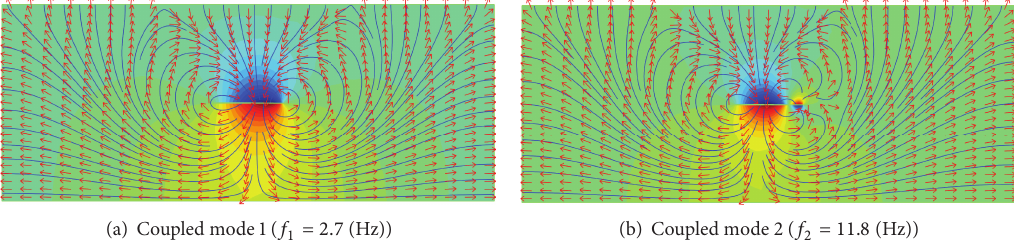
Figure 3: The colors pertain to the pressure field and the arrows to the velocity field in the case of 0 ∘ /90 ∘ /0 ∘ /90 ∘ /0 ∘ .